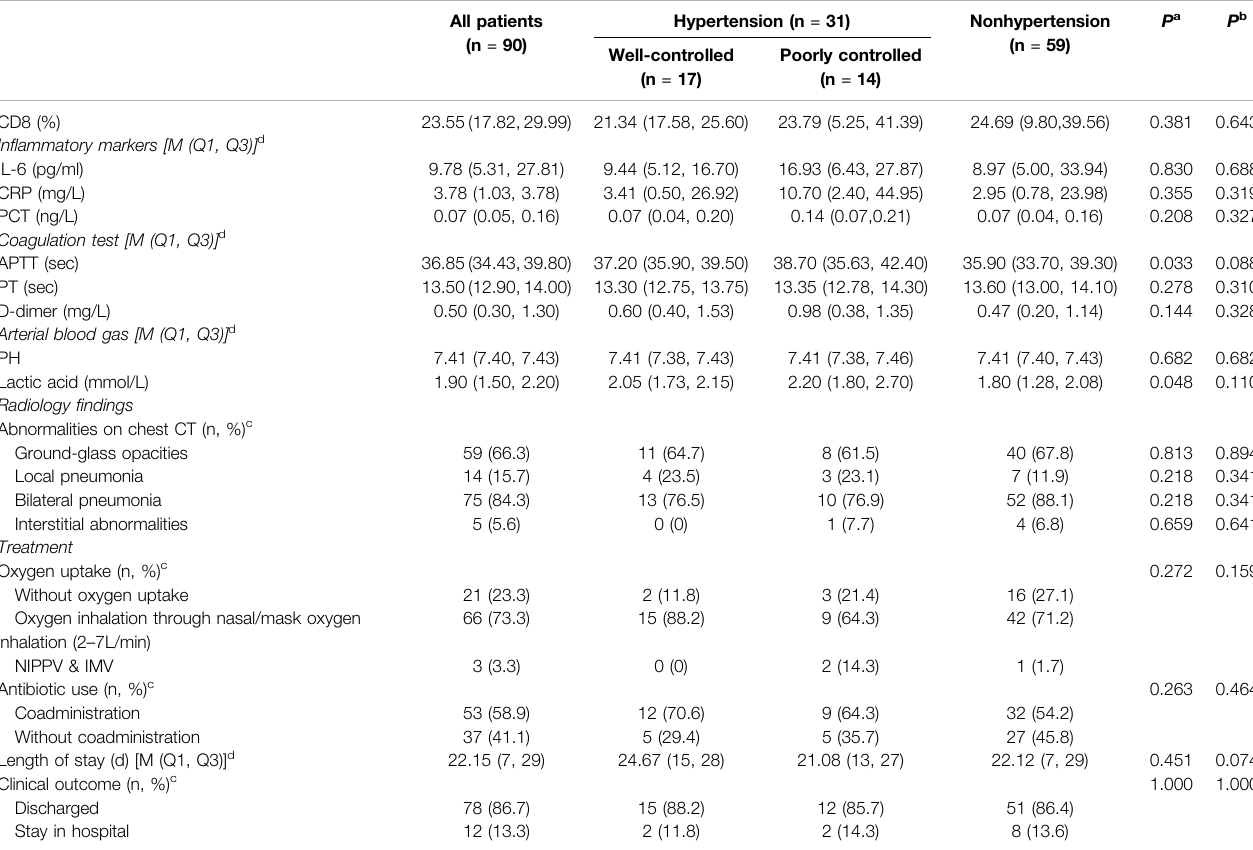
TABLE 1 | ( Continued ) The comparison of demographic and clinical characteristics, laboratory and radiology fi ndings, clinical measures, clinical outcomes, and severity of COVID-19 among well-controlled, poorly controlled, and nonhypertension groups. All patients (n =